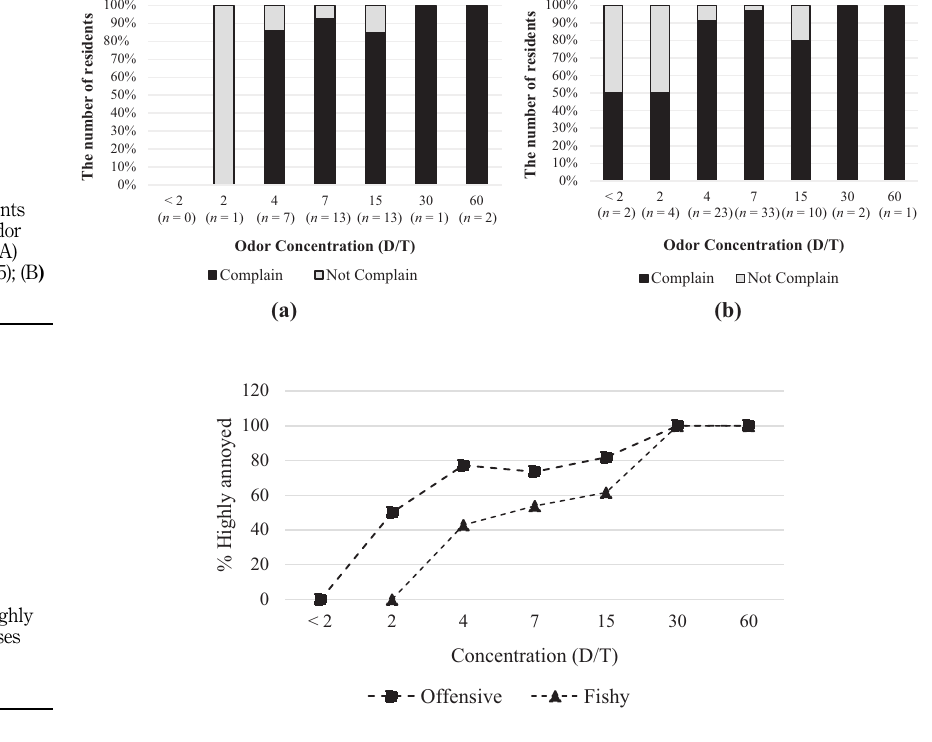
Figure 5. Percentage of highly annoyed responses from different hedonic